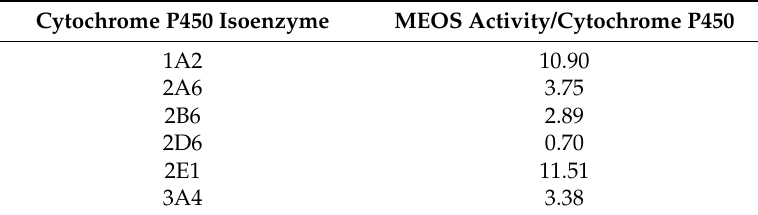
Table 2. Microsomal ethanol-oxidizing system (MEOS) and its cytochrome P450 isoenzymes. To assess the turnover number, MEOS activity (nmoles acetaldehyde/min) is calculated per nmole cytochrome P450, all expressed per mg of microsomal protein as published [192].